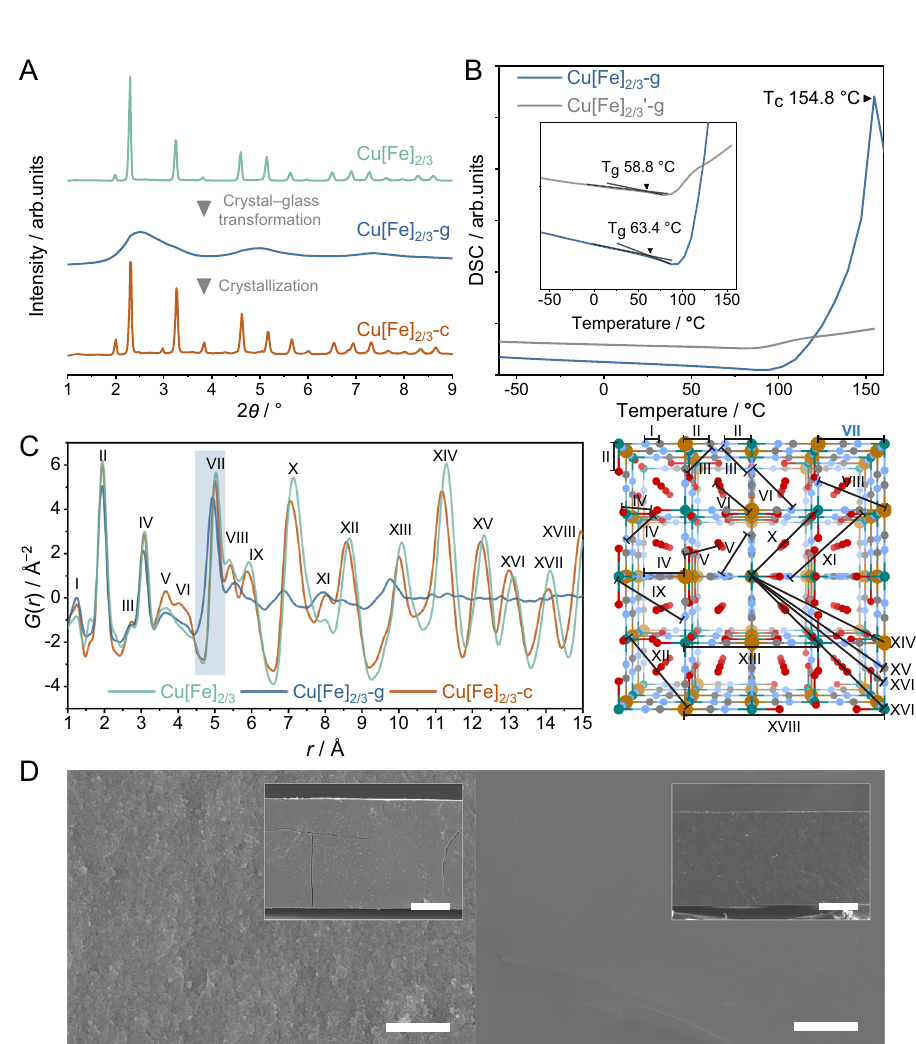
Fig. 2 Crystal – glass transformation and recrystallisation of Cu[Fe] 2/3 . A Synchrotron PXRD ( λ = 0.2020 Å) of Cu[Fe] 2/3 (green), Cu[Fe] 2/3 -g (blue), and Cu[Fe] 2/3 -c (brown). B Enthalpic response comparison between Cu[Fe] 2/3 -g (blue) and Cu[Fe] 2/3 '-g (grey) at 30 °C min − 1 . C Pair distribution function (PDF) and PDF peak assignment of Cu[Fe] 2/3 (green), Cu[Fe] 2/3 -g (blue), and Cu[Fe] 2/3 -c (brown). The blue highlight presents Cu – Fe correlation pair (label VII). The selected peak assignments are highlighted in the schematic diagram of the crystalline Cu[Fe] 2/3 . Cu, Fe, C, N, and O atoms are represented as green, brown, grey, blue, and red spheres, respectively. H atoms are omitted for clarity. D Comparison of cross-sectional SEM images of hot-pressed Cu[Fe] 2/3 (left) and Cu[Fe] 2/3 -g (right). Scale bar = 2 μ m and 100 μ m for enlarging and inset, respectively. The de fi nition of the samples ’ abbreviations can be found in Table 1. Source data are provided as a Source Data fi